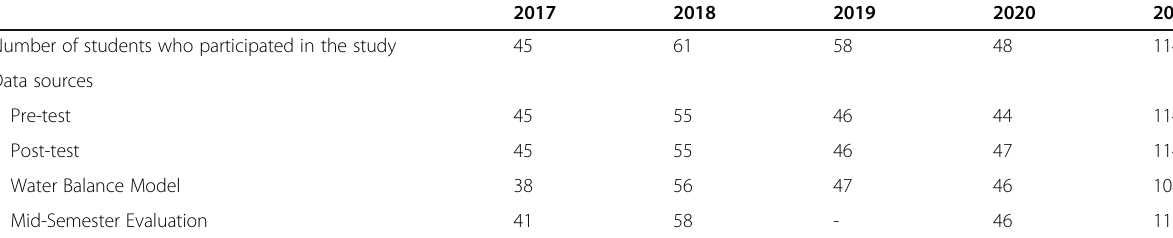
Table 2 Number of students who responded to the